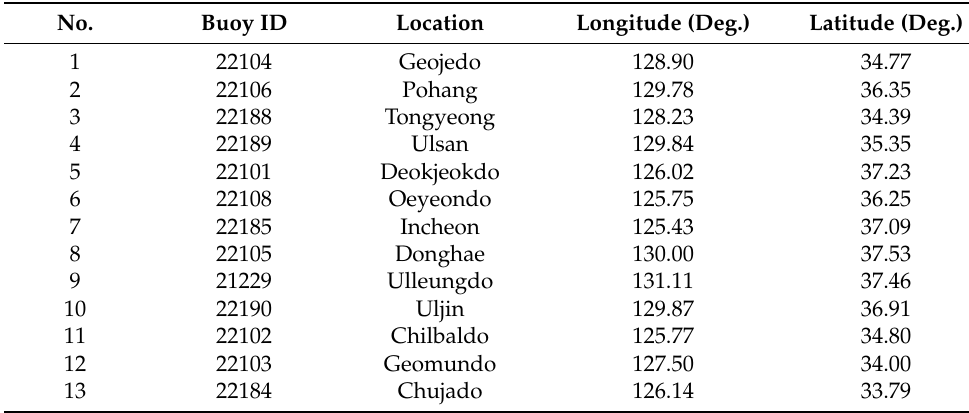
Table 2. Location information of ocean data buoys